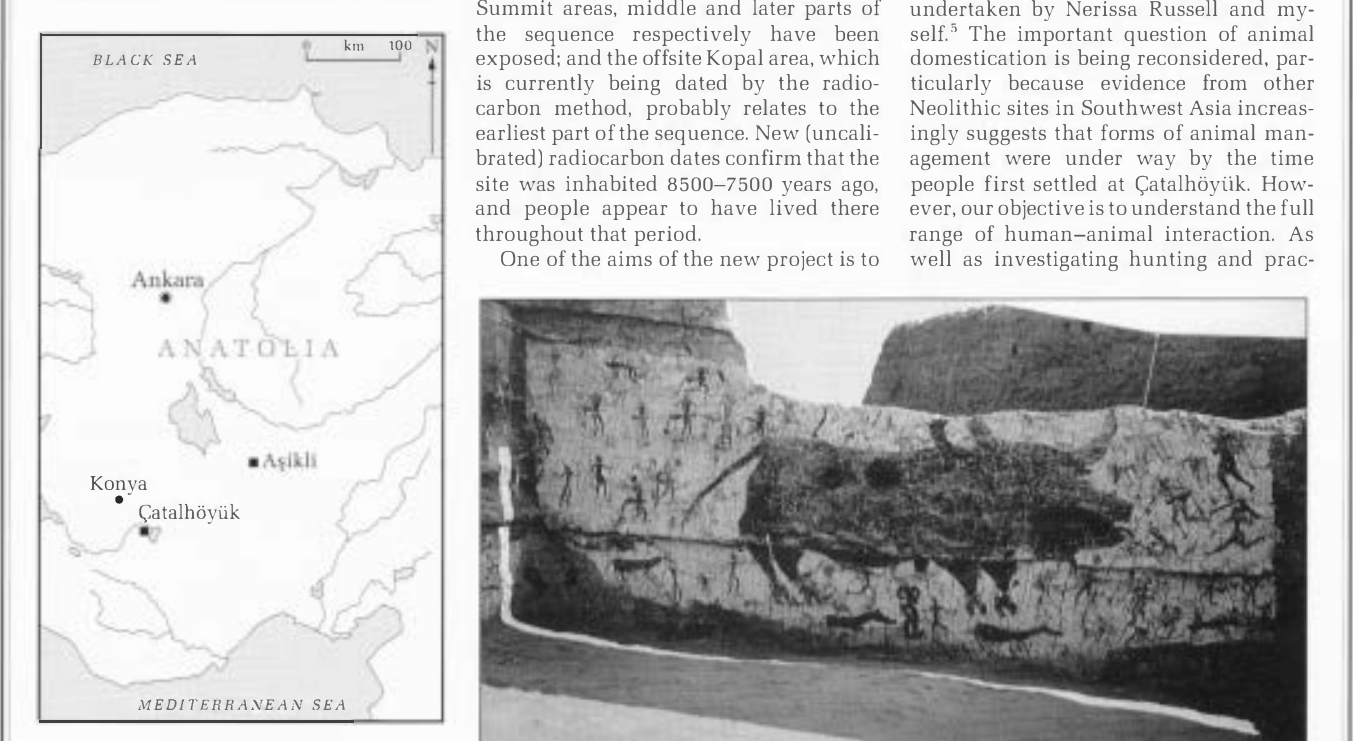
Figure 1 Central Anatolia, showing the Figure 2 A wall painting from (:atalhoyiik level location of the two Neolithic sites men­ tioned in the text: (:atalhoyuk and A$ikli. bull surrounded by human